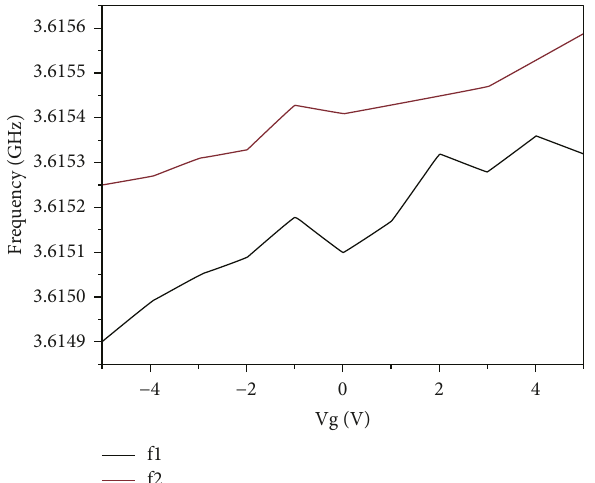
Figure 13: Te resonance frequency fgure of the AlN-based FBAR sensor after adding ethanol, the horizontal axis is frequency while the vertical axis is S 11